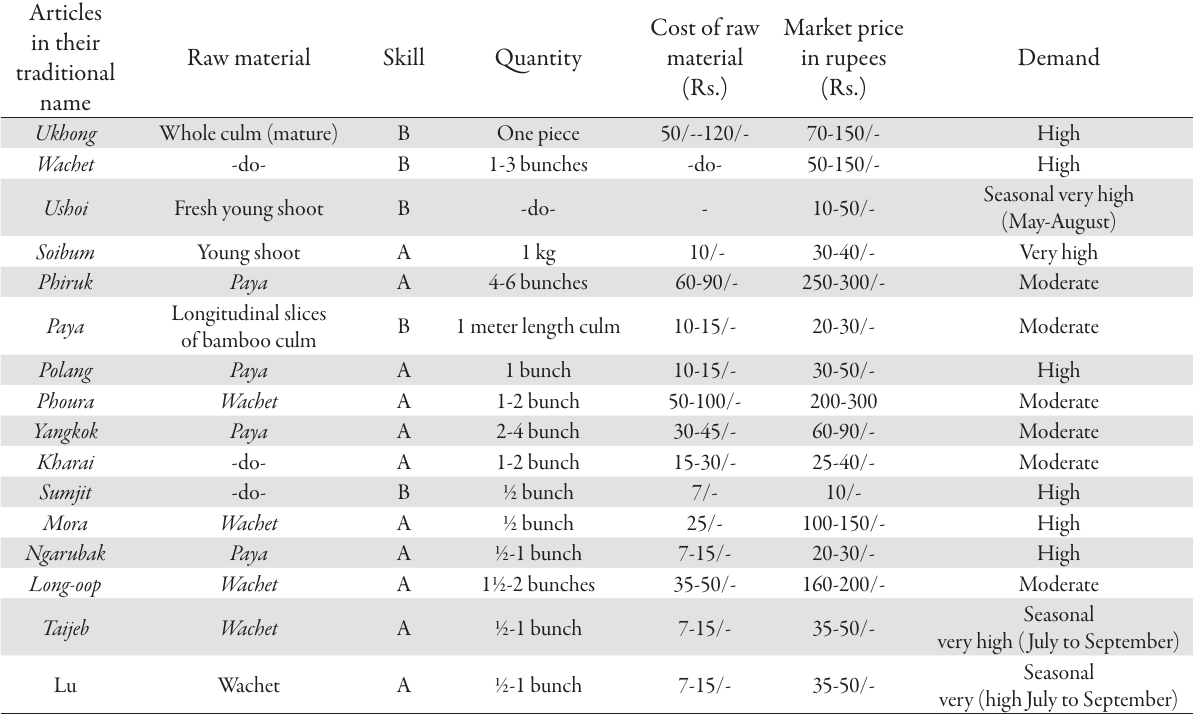
Tab. 1. Value added articles of B. tulda having commercial